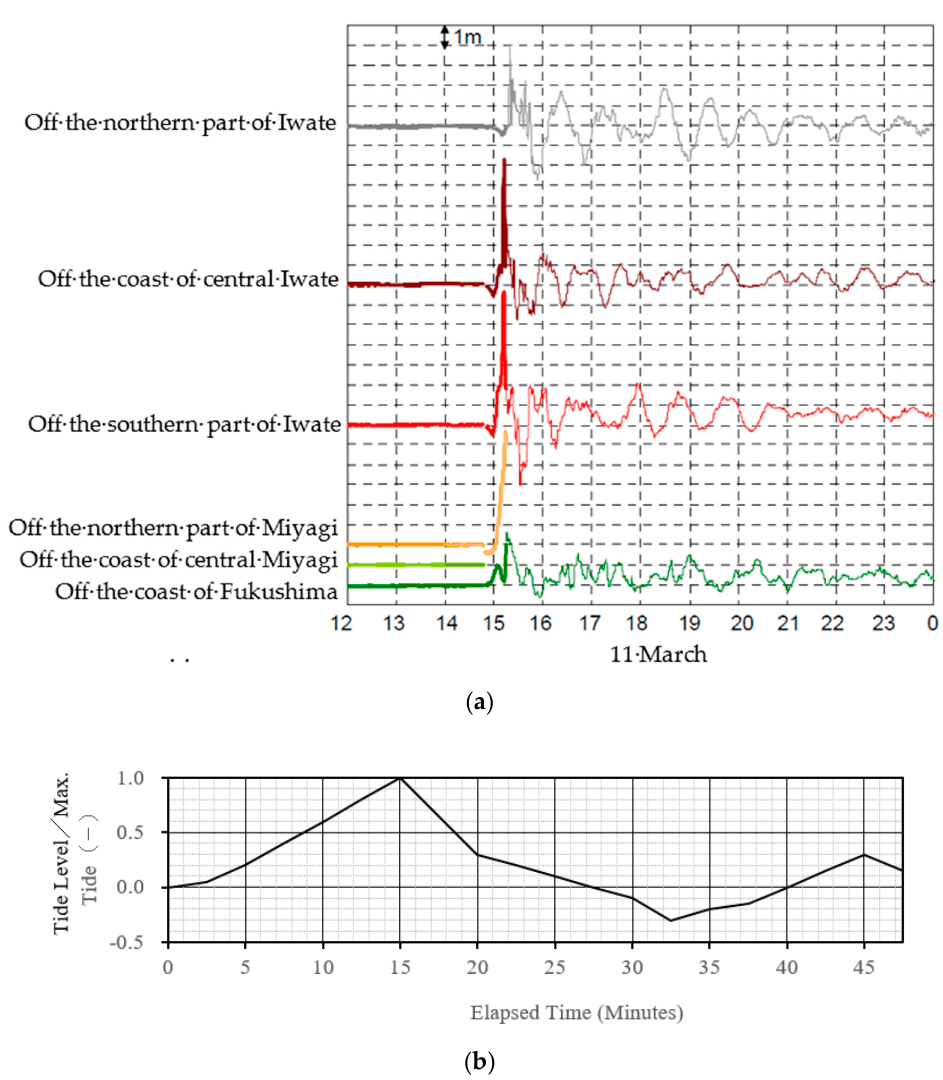
Figure 10. (a) Tide level data of the 2011 Great East Japan tsunami (from No.1231 Technical Report of the port and airport research institute of the Japanese Government); (b) input data of off-shore tide levels observed off of the Miyagi Prefecture. Adapted from Figure 3.2.3 of Technical Note No.1231 of PARI 2011) [21] with permission from the publisher, Japan National Research and Development Institute, (2020) .